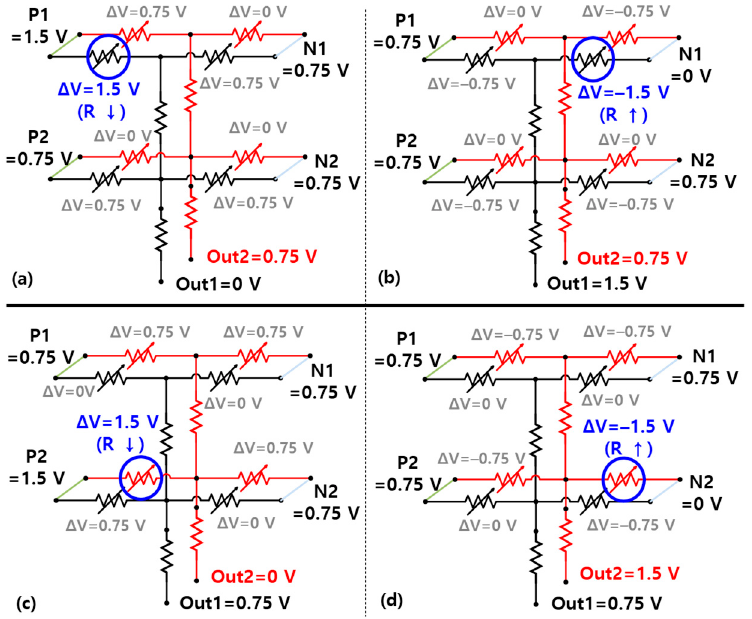
Figure 6. Simplified circuit diagrams of the 3D vertical synapse during the training procedure showing the voltages applied to ( a ) P1-Out1; ( b ) N1-Out1; ( c ) P2-Out2; and ( d ) N2-Out2 memristors when training Figure 4a and b.